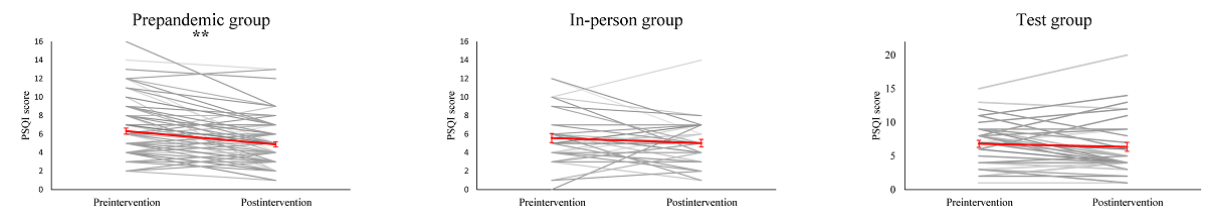
Figure 4. Change in subjective sleep quality. Black lines depict change for individual participants, and red line indicates the mean change and standard errors in the group. Change in self-reported sleep quality was significant in the control group (pre-pandemic) but in neither of the groups trained during the pandemic. PSQI = Pittsburgh Sleep Quality Index; * P